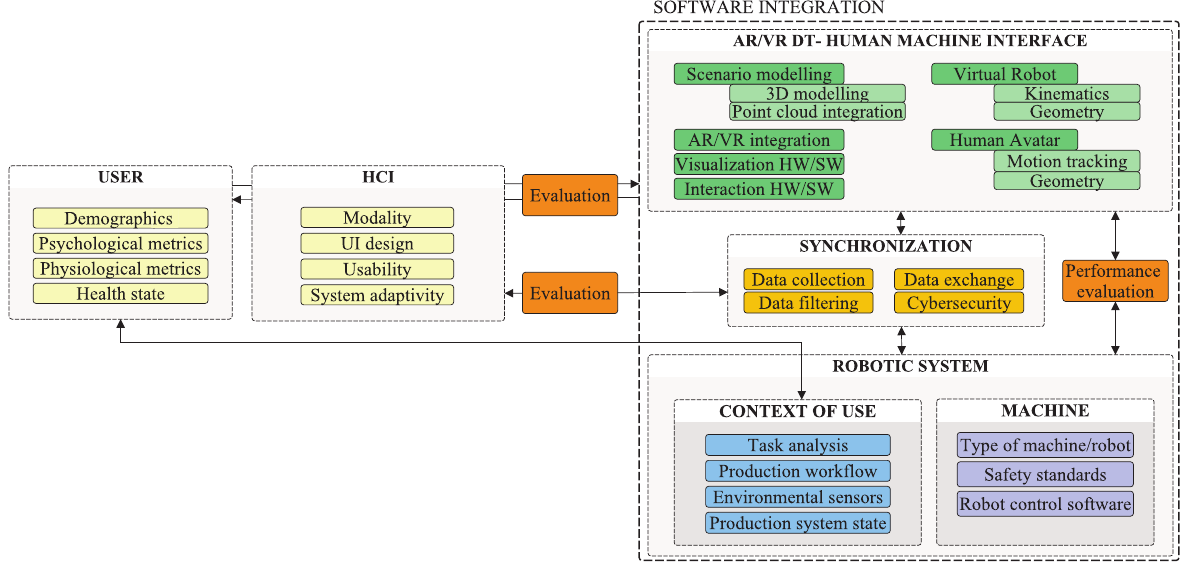
Fig. 3. Software integration architecture for UCD based HRC systems adopting DT AR/VR